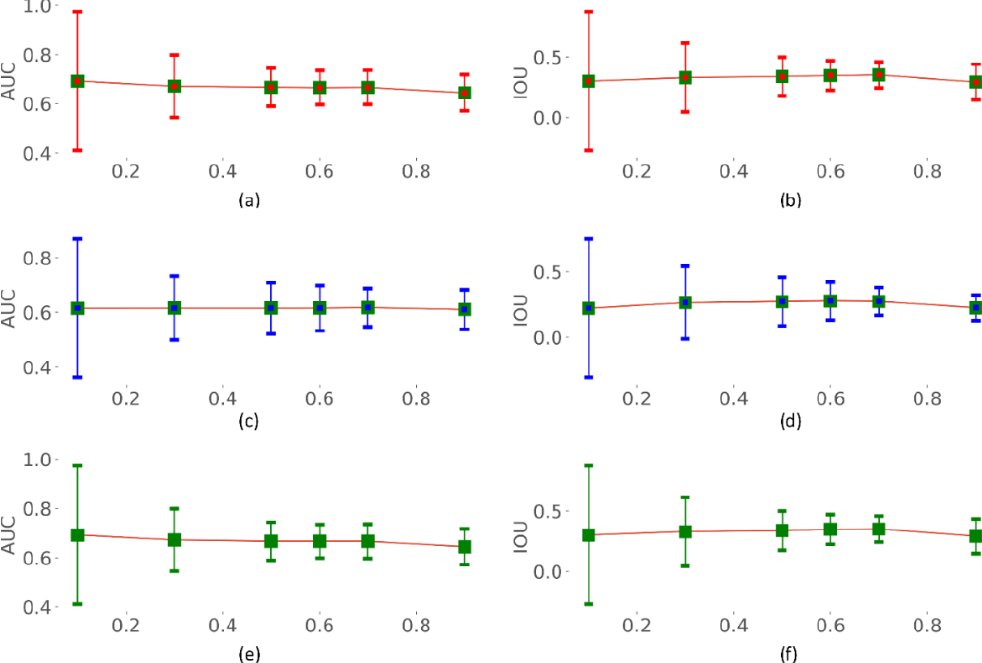
Figure 9. AUC and IOU measured for varying values of τ . ( a , b ) using aleatoric uncertainty; ( c , d ) using epistemic uncertainty; and ( e , f ) using total (aleatoric + epistemic) uncertainty.